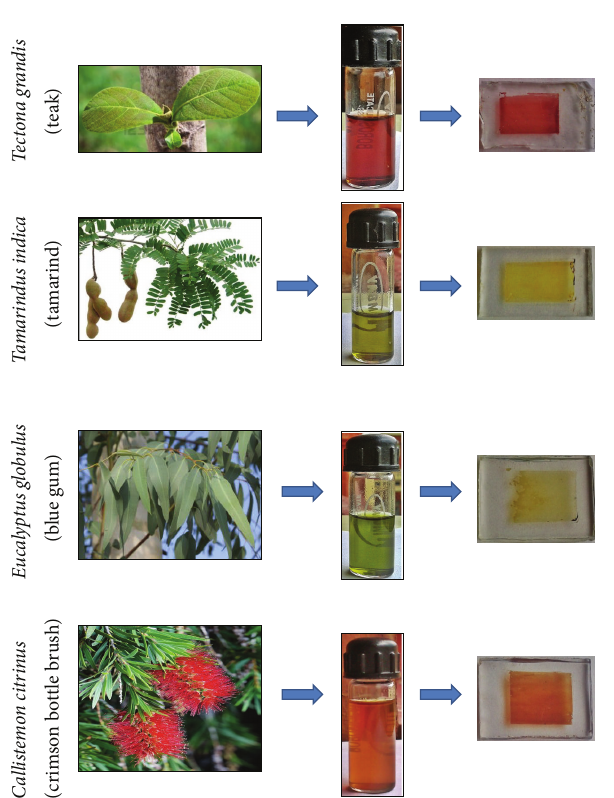
Figure 2: Plants, extracted dyes, and the dye-loaded TiO 2 electrode.